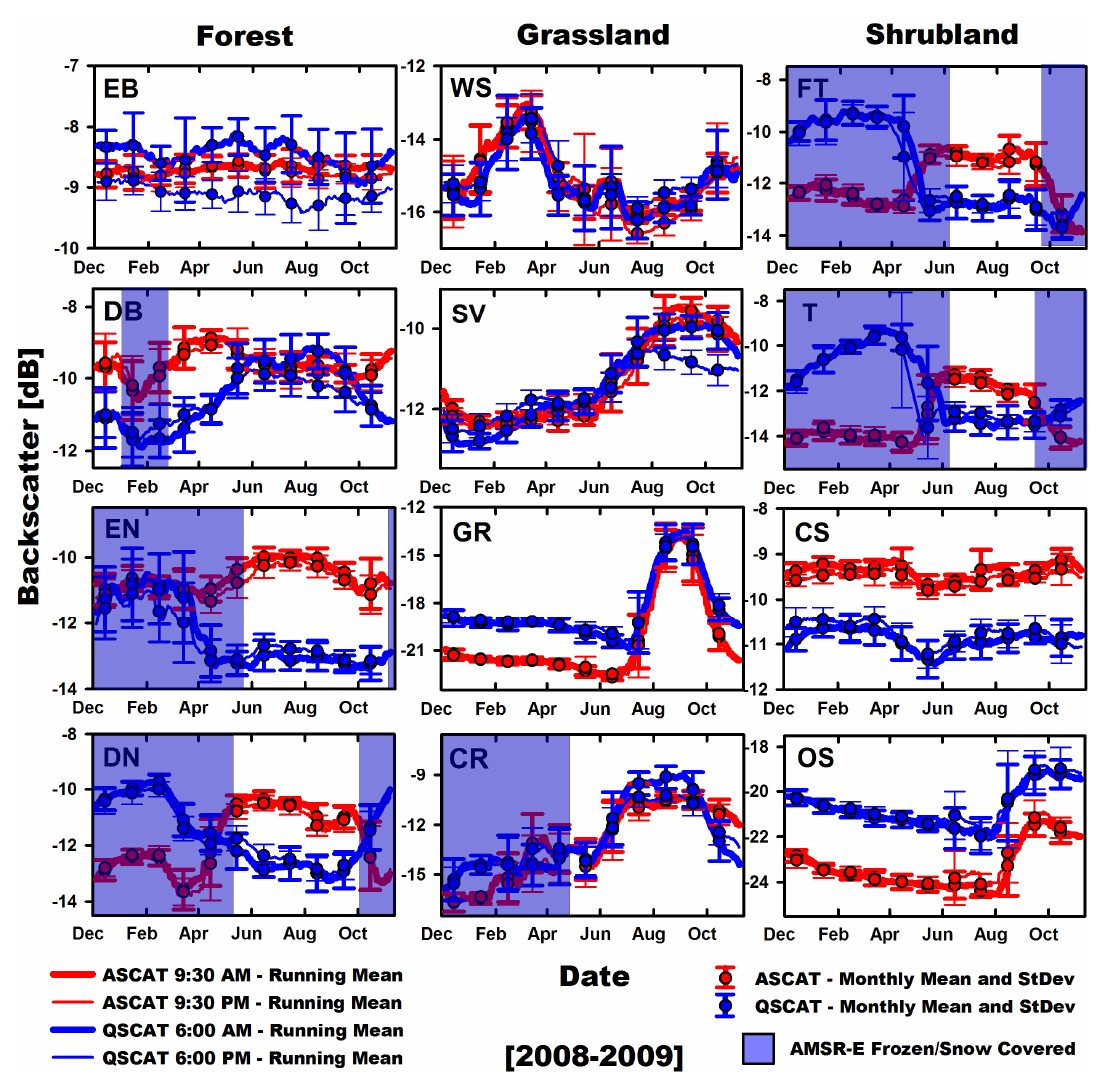
Figure 3. Daily time series from morning (A.M.) and evening (P.M.) overpasses of C-band ASCAT and K u -band QSCAT backscatter for 12 selected sites (Figure 2) during mission overlap (11/2008–11/2009).